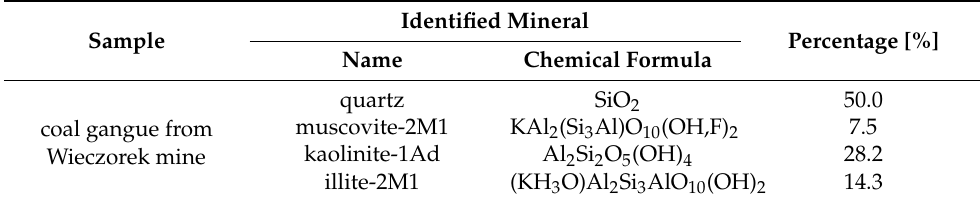
Figure 1. XRD of coal gangue from Wieczorek coal mine. On the y -axis, the relative intensity of the diffracted beam. Table 1. Percentage of identified minerals in gangue from the Wieczorek mine.